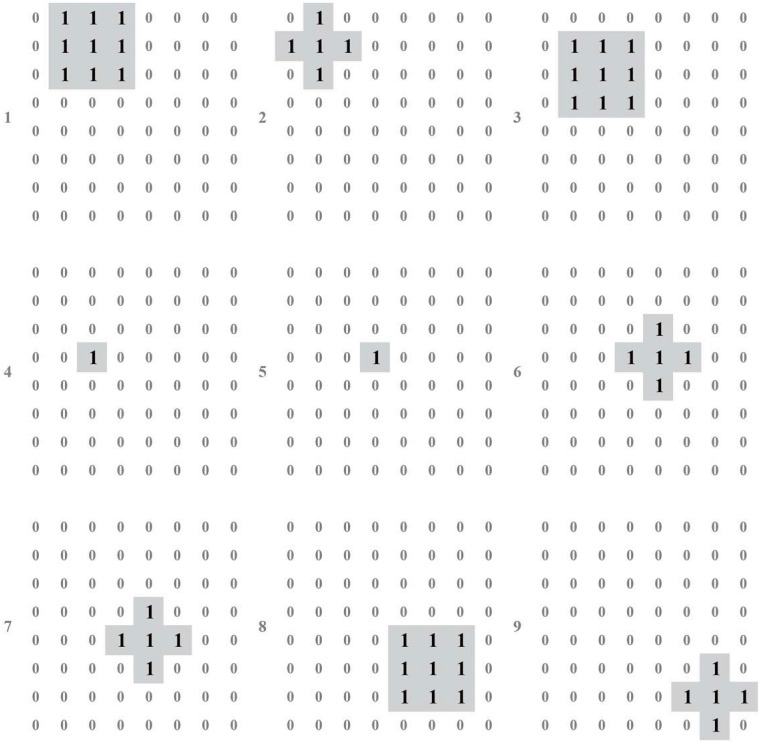
Output of layer 1.